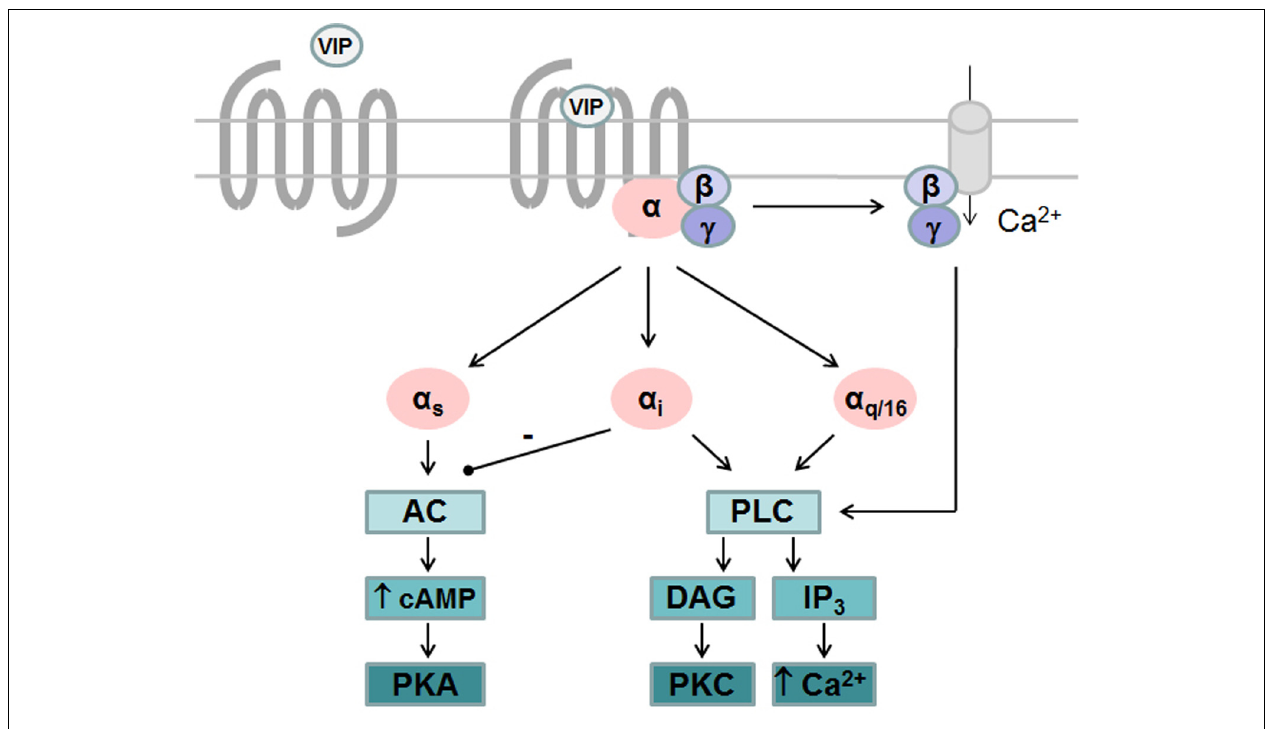
FIGURE 1 | G protein-dependent signaling pathways activated by VPAC receptors. VPAC receptors are preferentially coupled to G α s leading to activation of adenylate cyclase (AC) and subsequent cAMP production and activation of protein kinase A (PKA).VPAC receptors are able to activate phospholipase C (PLC) pathway after coupling to G α i, G α q, or G α 16 and